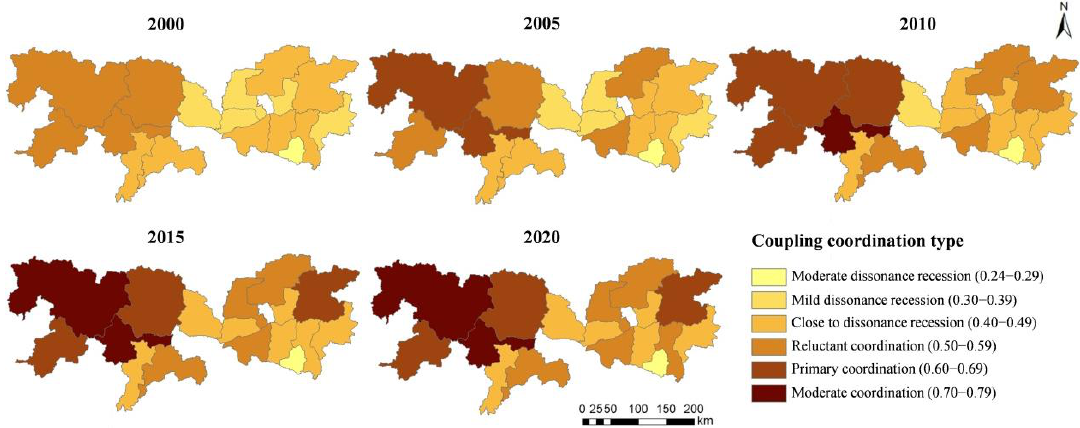
Figure 5. Spatiotemporal distribution of the coupling coordination degree between residents’ livelihoods and land ecosystem services in the ORTTR from 2000 to 2020.